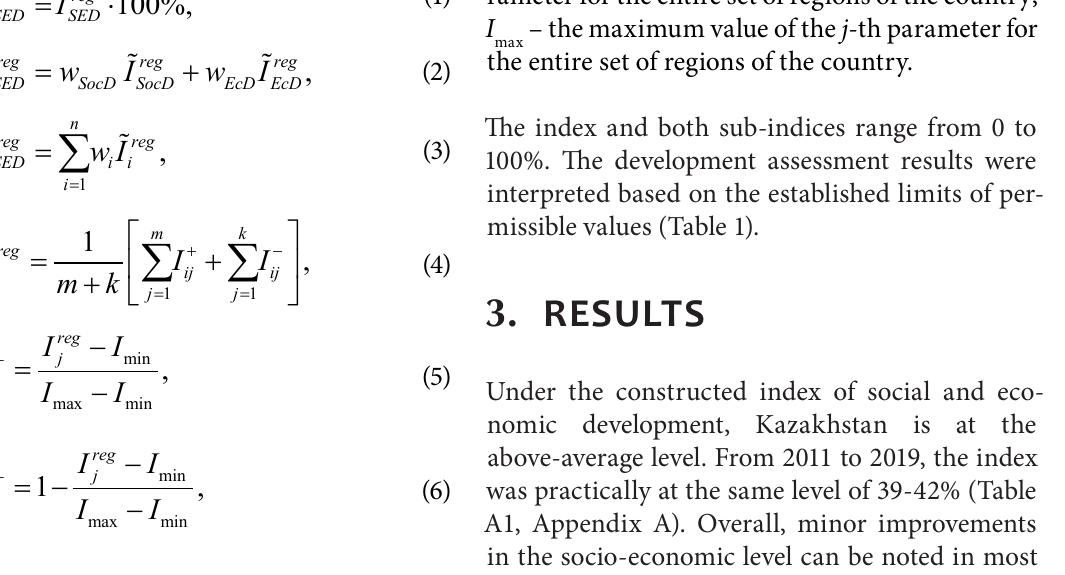
Table 1. Interpretation of the index of a social and economic development and its sub-indices